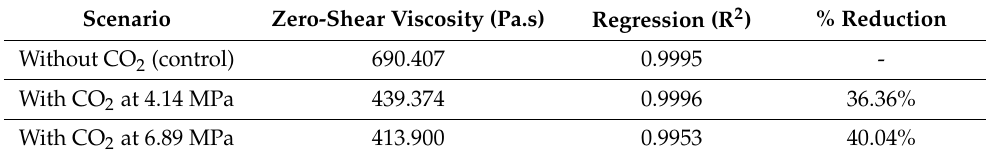
Table 4. Zero ‐ shear viscosity of Pellethane at three different scenarios.